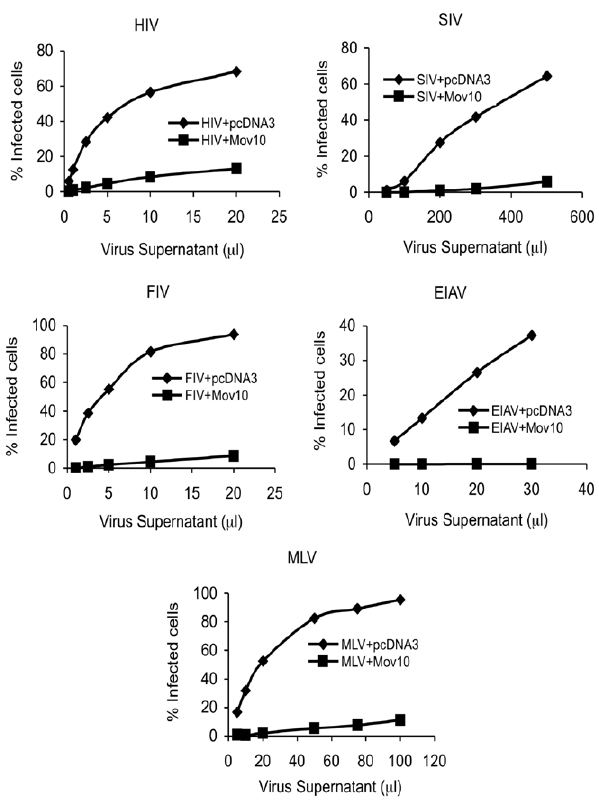
Figure 4. Broad inhibition of infectious retroviruses by Mov10. Virions derived from 293T cells transfected with various viral plasmids (as described in Materials and Methods) and either pcDNA3 or pcDNA3- Mov10 were used to infect HeLa cells. The % infected cells represents the percentage of GFP-positive cells in the cell population.